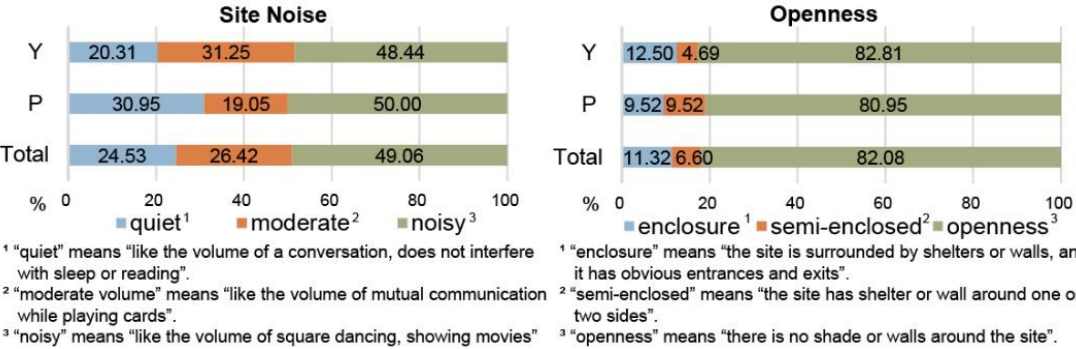
Figure 8. Survey statistics of respondents ’ environmental comfort preferences.